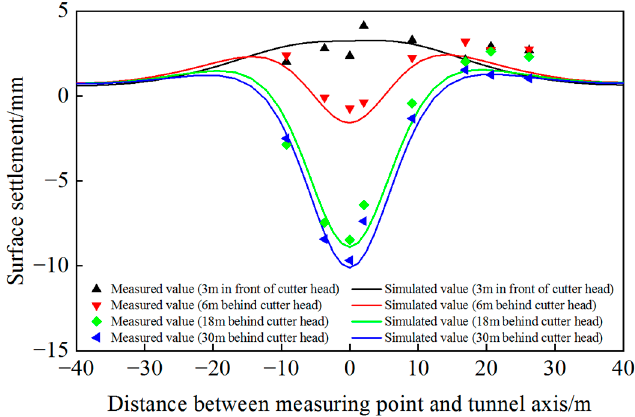
Figure 29. Surface settlement at TY-56.